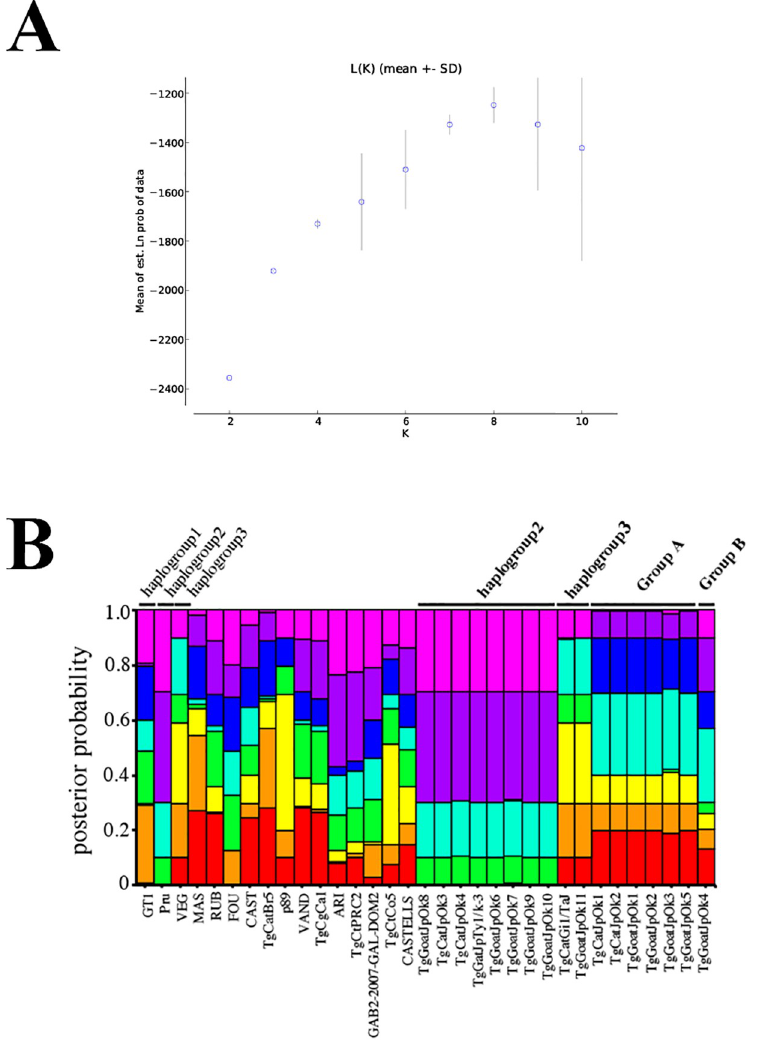
Fig 2. Population structural analysis of reference clones and Japanese isolates. (A) STRUCTURE program indicated that K = 8 is the most probable score, consistent with previous findings [13]. (B) Genetic composition of T . gondii for K =